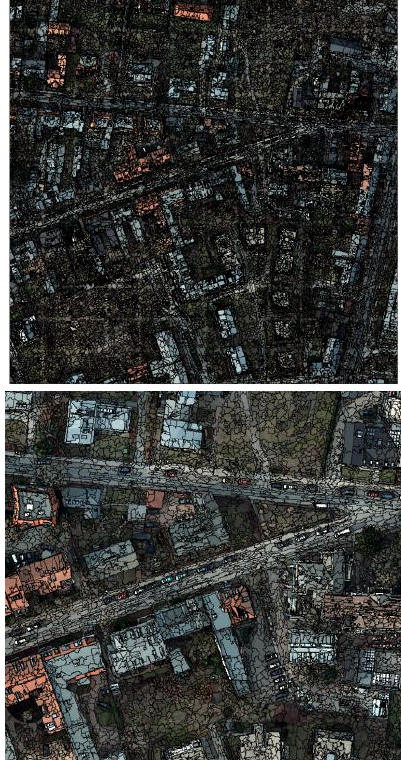
Figure 1. Multiresolution segmentation results in two